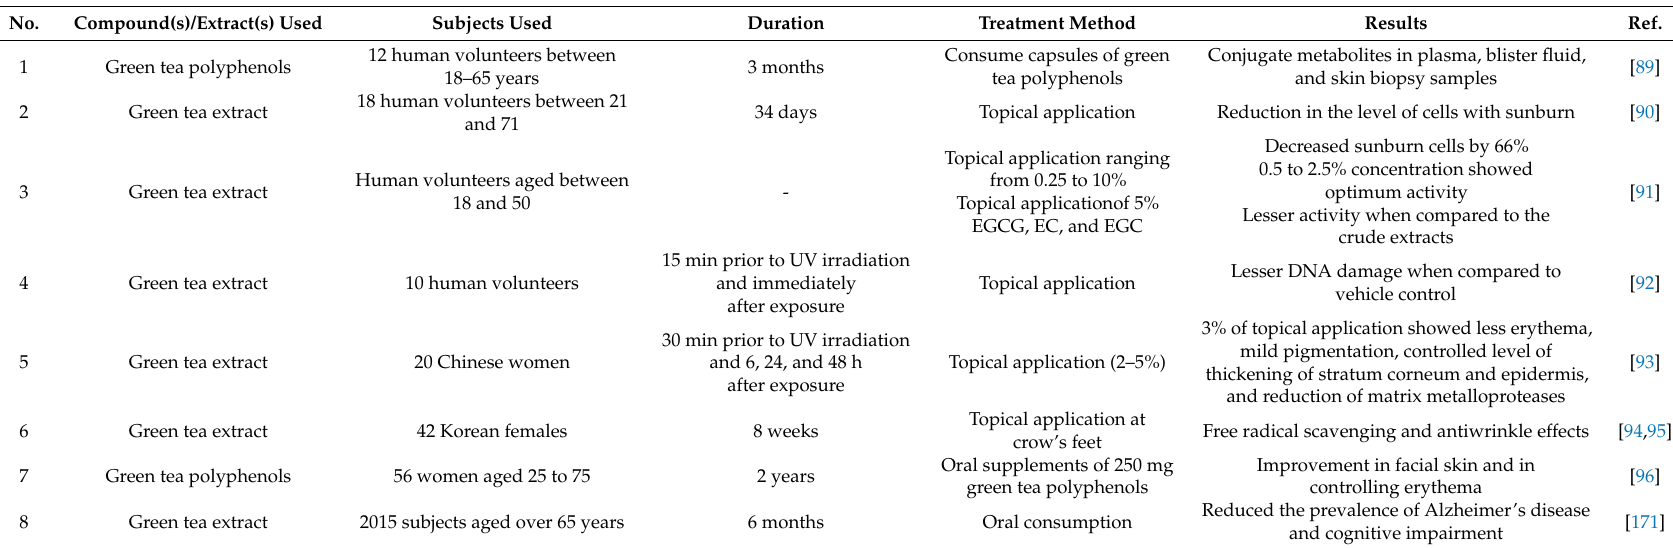
Table 2. Effects of green tea supplementation on photoaging, stress resistance, neuroprotection, and associated health complications: outcomes of clinical trials.